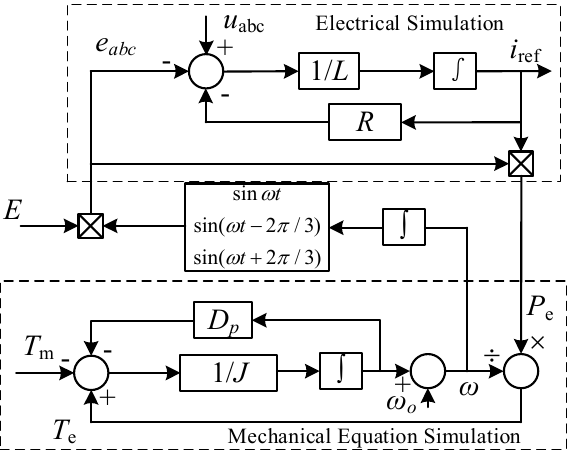
Figure 2. Control diagram of the virtual synchronous machine (VSM).